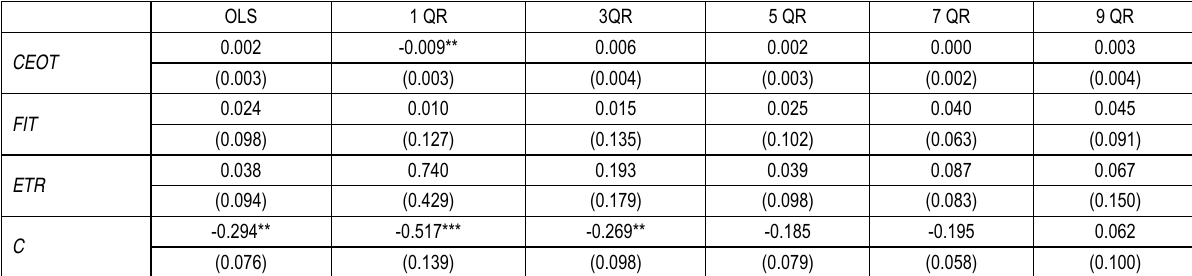
Table 4 (cont.). The results of quantile regression on abnormal return ( AR )